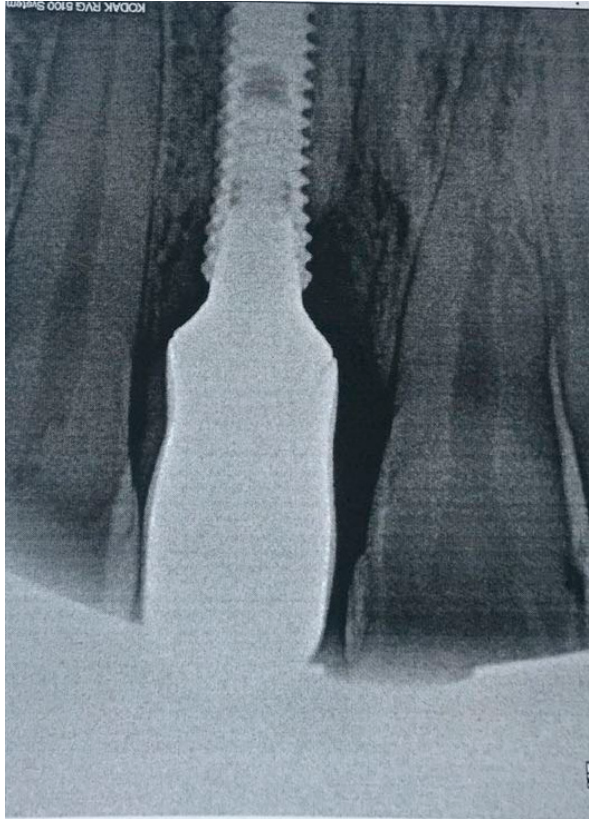
Figure 6. X-ray of patient before treatment in position 1.1 of dental implant.